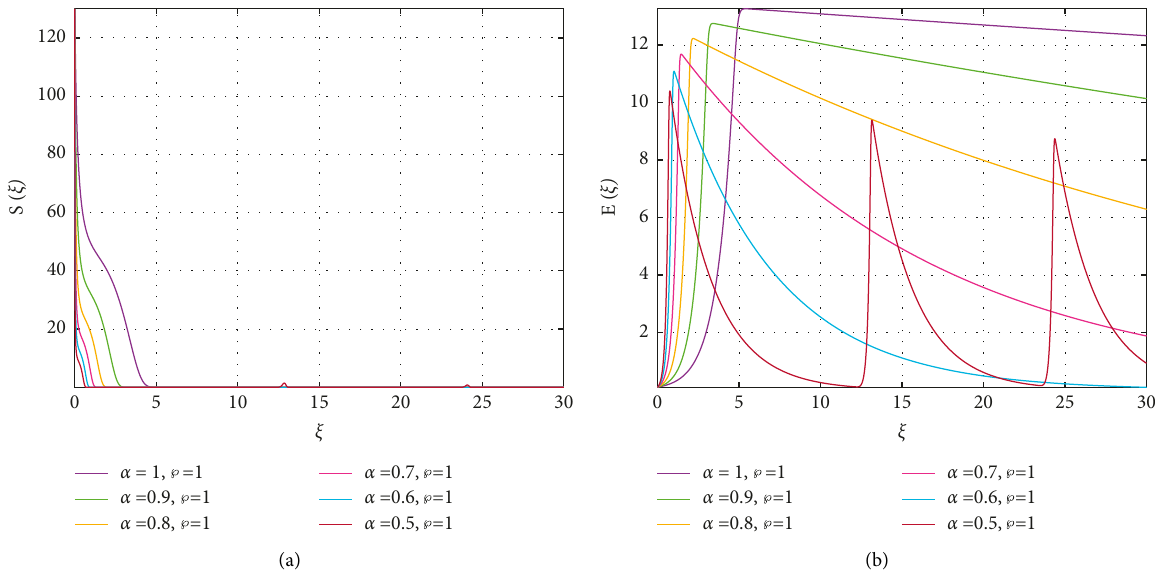
Figure 10: (a) Displays of susceptible individuals S ( ζ ) (b) Displays of exposed individuals E ( ζ ) using an another numerical approach for decreasing fractional-order α and fixed fractal-dimension ℘ �